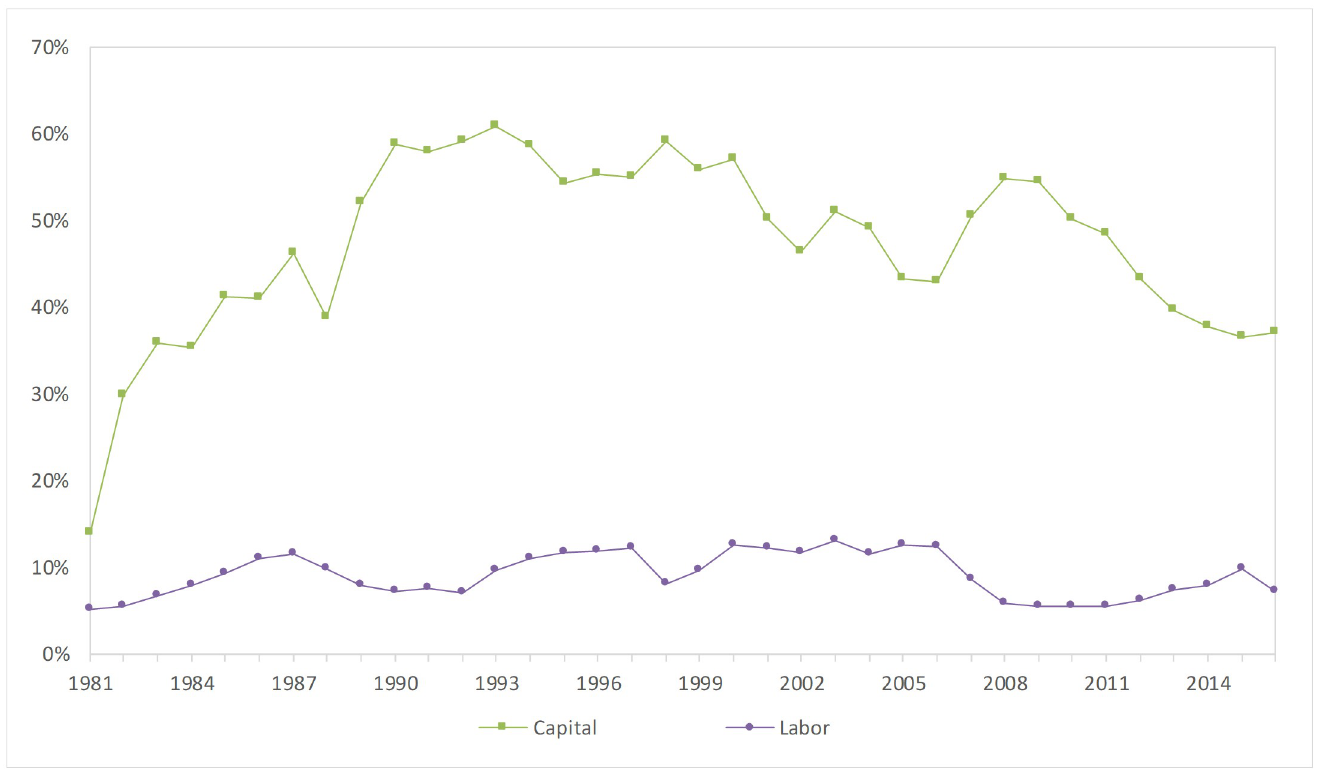
Fig 1. Trend of the input factor contribution